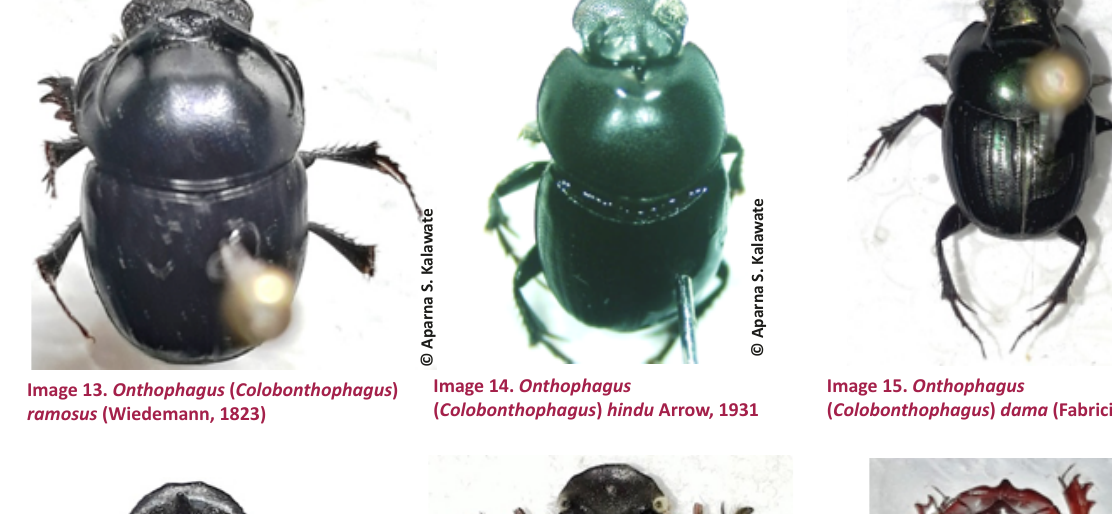
Image 16. Heliocopris bucephalus (Fabricius, 1775)